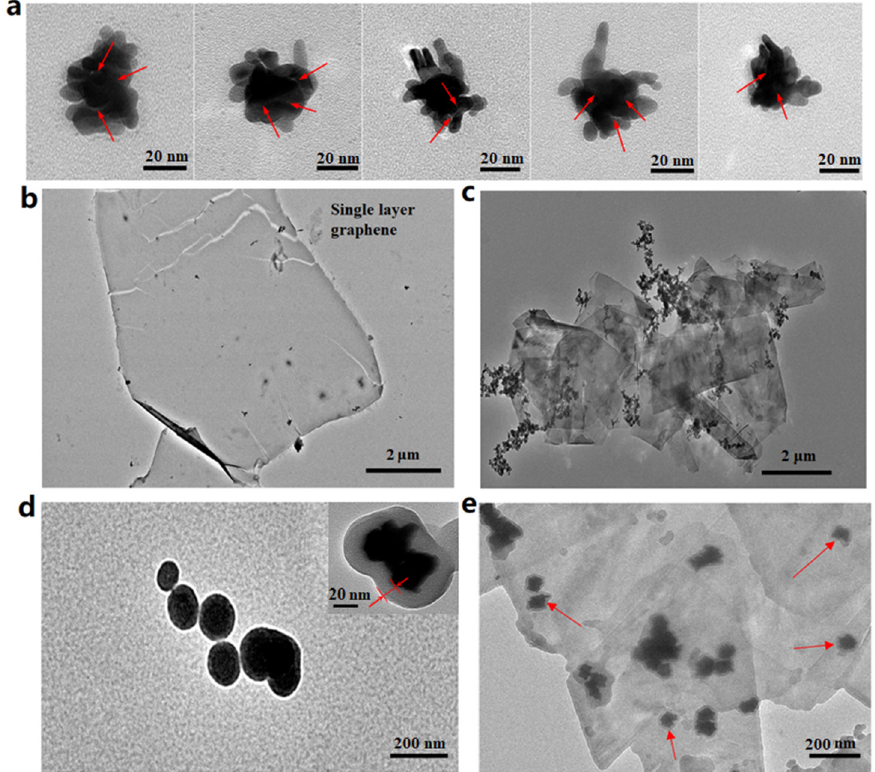
Figure 5. ( a ) TEM image of P-GERTs; ( b ) TEM image of monolayer graphene; ( c ) TEM image of GP-GERTs; ( d ) TEM image of (MS) P-GERTs; ( e ) TEM image of MS-GP-GERTs.